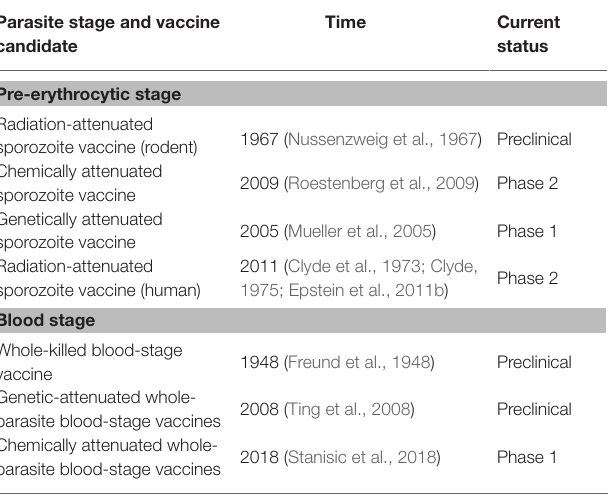
TABLE 1 | The time table of the development of whole parasite